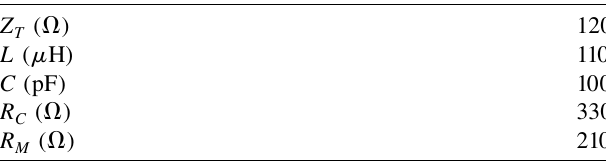
TABLE I. Measured parameters for the induction units. Z ( (cid:8) ) T